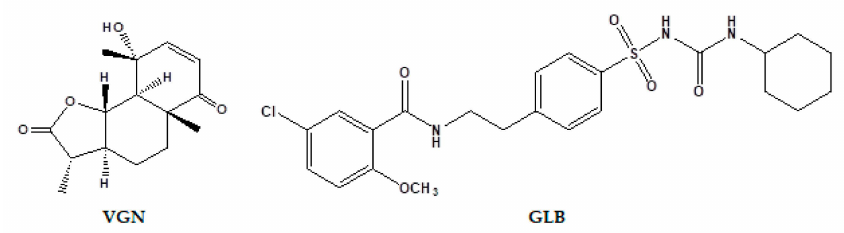
Figure 1. Structures of vulgarin (VGN) and glibenclamide (GLB). Table 1. Effect of GLB, VGN and their combinations on the FBG levels in STZ-induced